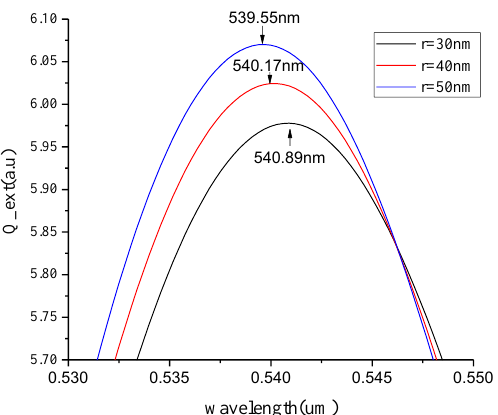
Figure 7. The absorption spectra of spherical gold nanoparticles of different sizes (30, 40, and 50 nm) with incident light wavelength of 530 – 550 nm.